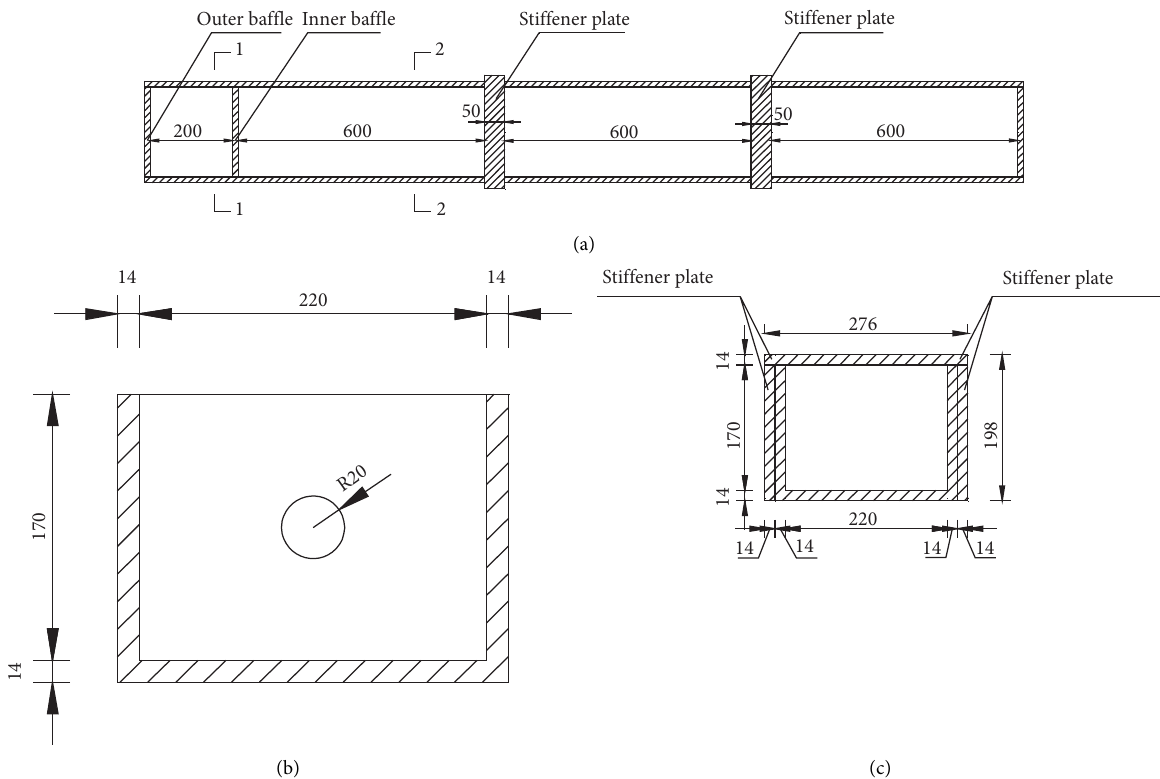
Figure 3: Plan and section of the laboratory model test chamber. (a) Plan of the laboratory model test chamber. (b) Section 1-1. (c) Section 2-2.